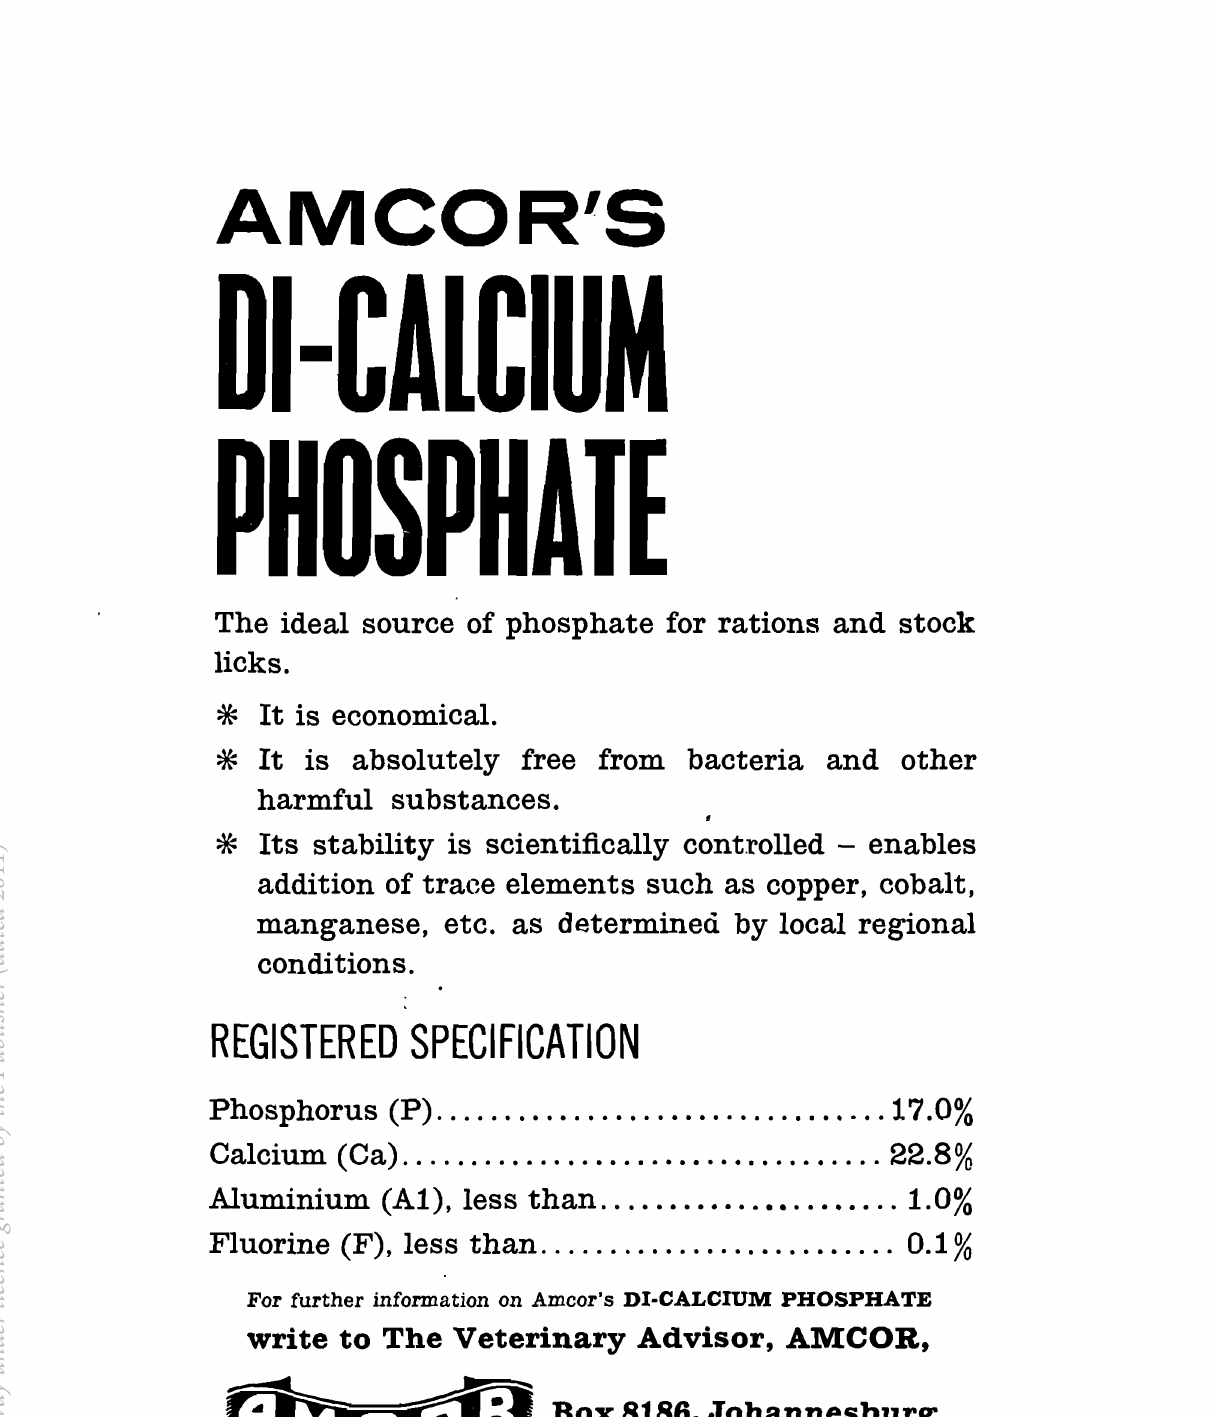
The ideal source of phosphate for rations and stock